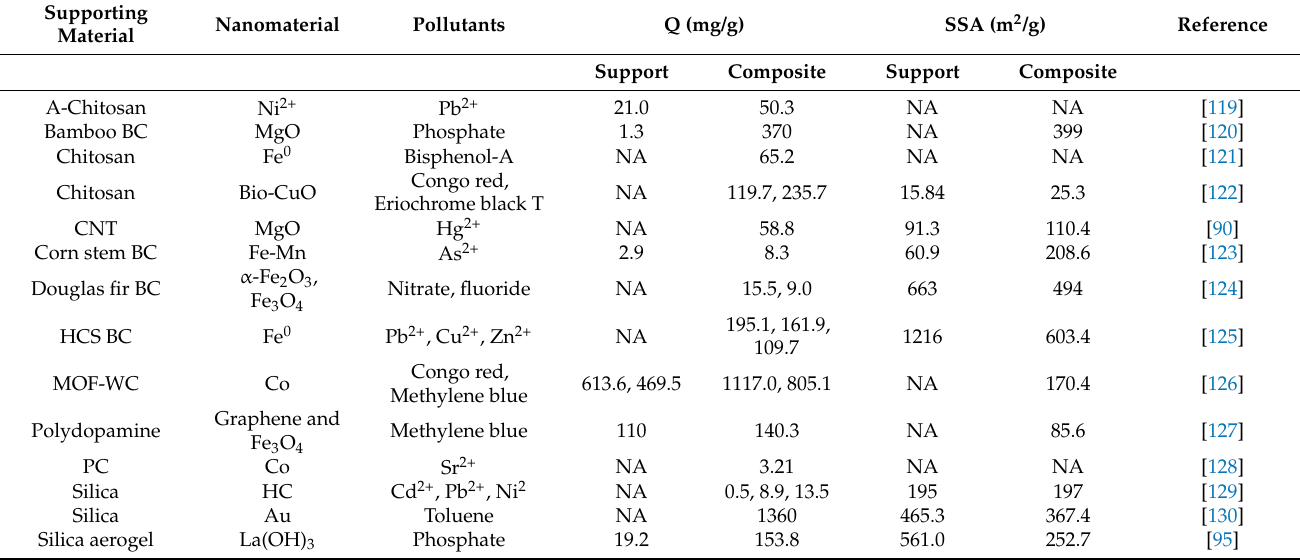
Table 3. Adsorption of pollutants using immobilized